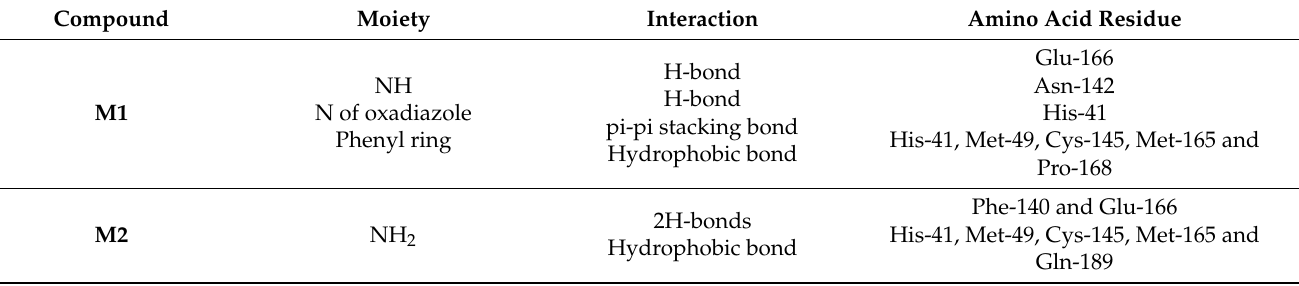
Table 2. Molecular modeling of the shortlisted compounds ( M1 – M5 ) within the binding active site of SARS-CoV-2 M pro when compared to Compound 13